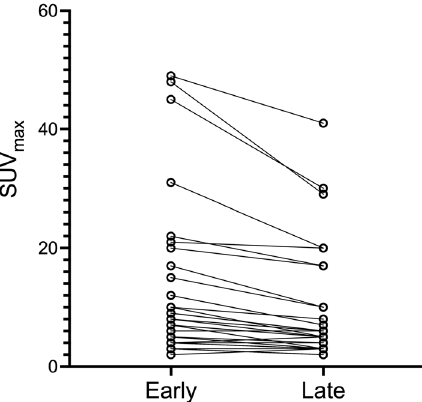
Fig. 3 Difference in SUV max (washout rate) between early and late acquisition (per-lesion site basis)